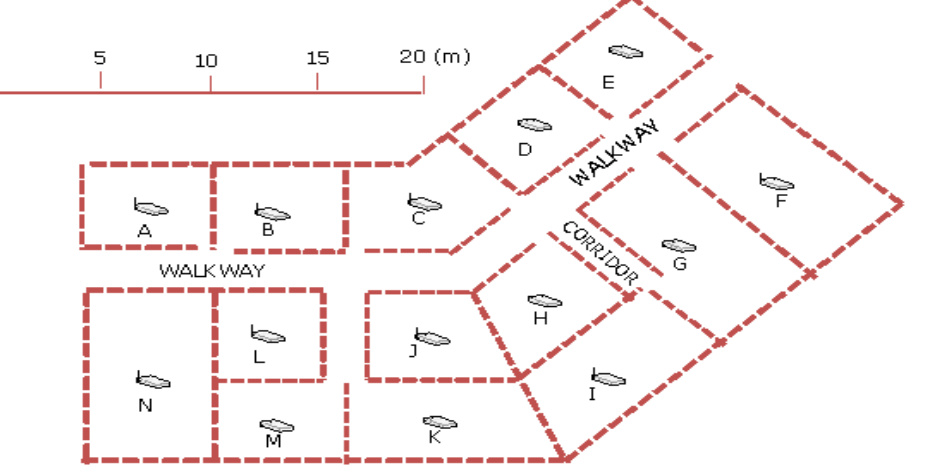
Figure 3. Floor plan showing the distribution of access points in the test